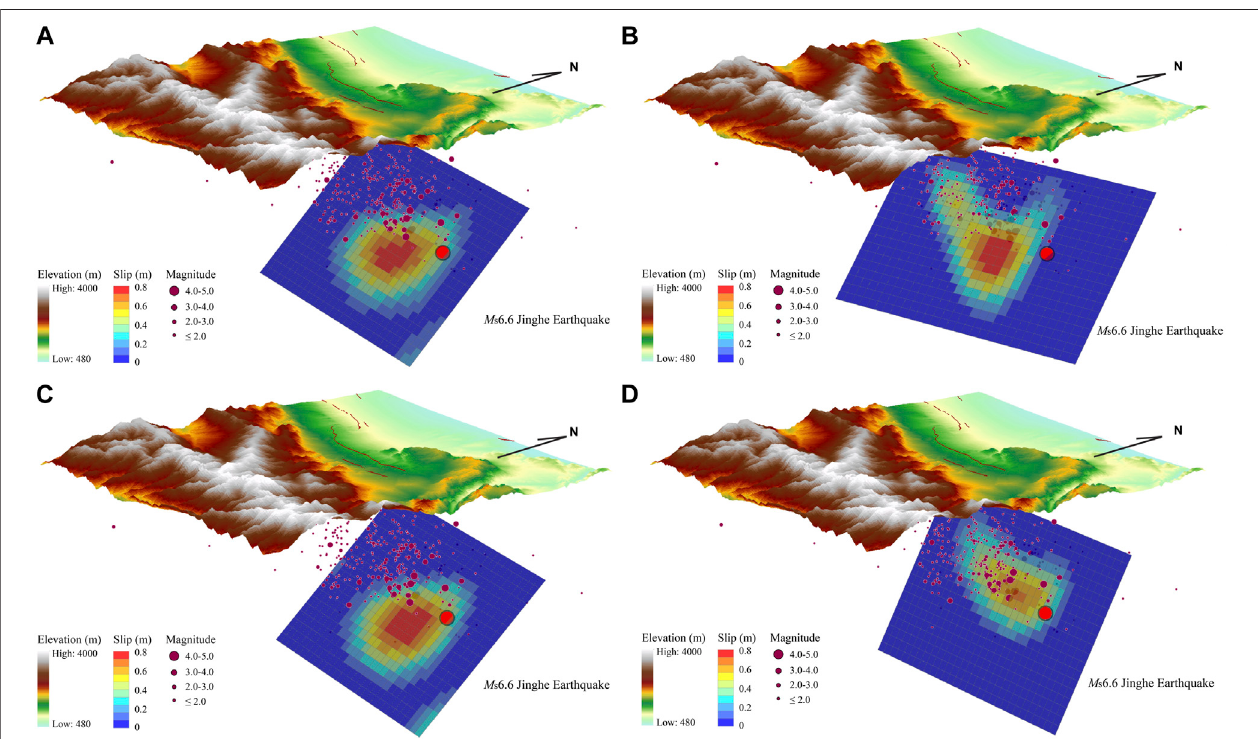
FIGURE4| 3D stereograms of the Jinghe earthquake. The red lines on the topography denote active faults. The black arrow points north. The largest red dot indicates the mainshock. The dark red dots indicate the spatial distribution of precise located aftershocks (from Fang et al. (2017), personal communication). The red to blue shading indicates the amount of slip from large to small on the fault slip plane. Each patch is 1.0 × 1.0 km 2 . For clarity, the terrain elevation is 1.5 times the gain. Slip distribution are constrained by focal mechanism solutions from (A) IPGP, (B) CENC, (C) GCMT, and (D)